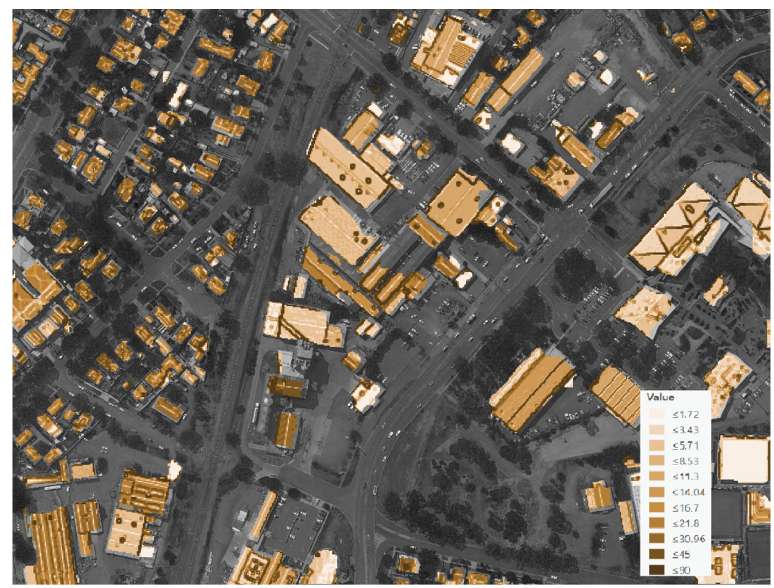
Figure 4. Roof tilt angle raster layer calculated using BHM and QGIS Slope function.